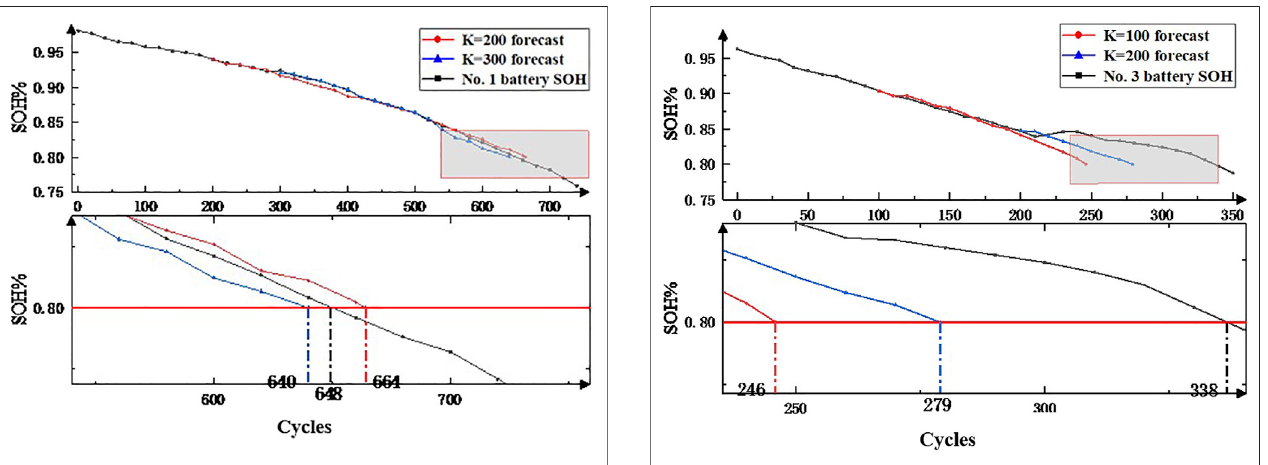
FIGURE 6 | Prediction results of the improved particle fi lter algorithm for No. 1 battery.